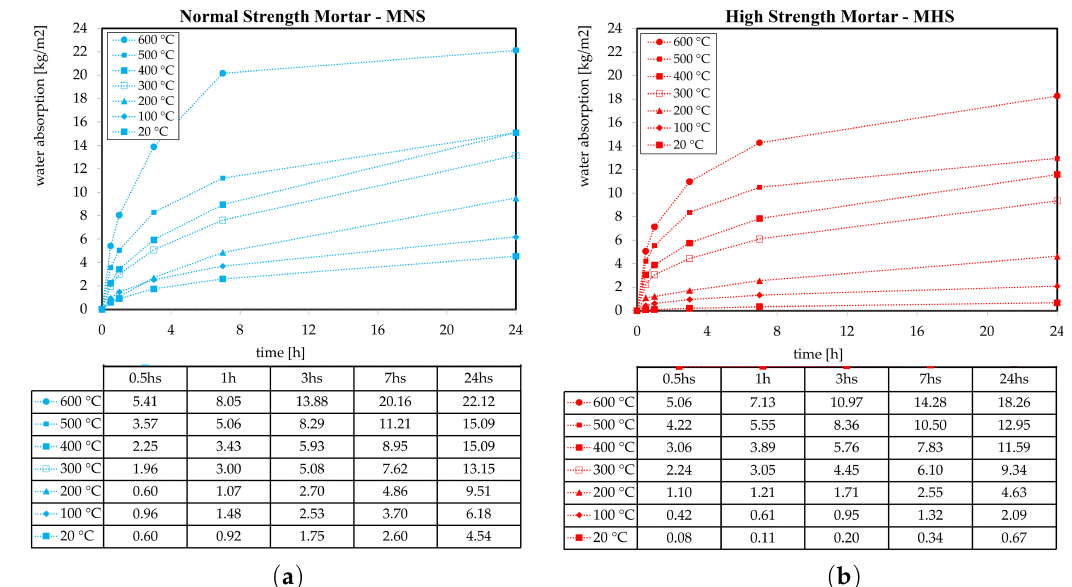
Figure 7. Capillarity water absorption coefficient of ( a ) MNS and ( b ) MHS, at several times of immersion (0 h, 0.5 h, 1 h, 3 h, 7 h and 24